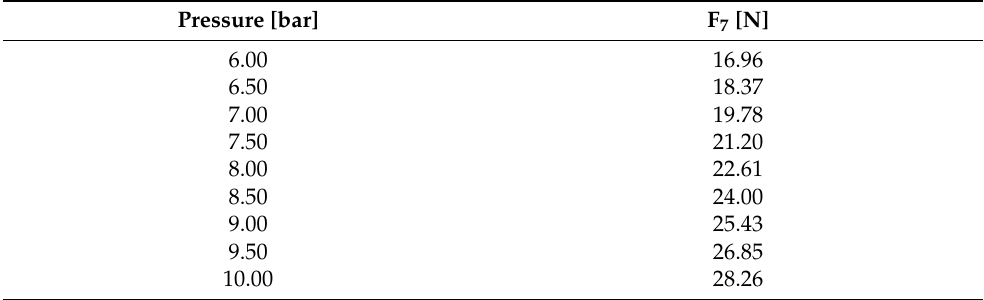
Table 2. Values of the pushing force (F 7 ) according to the values of pressure in the chamber of the